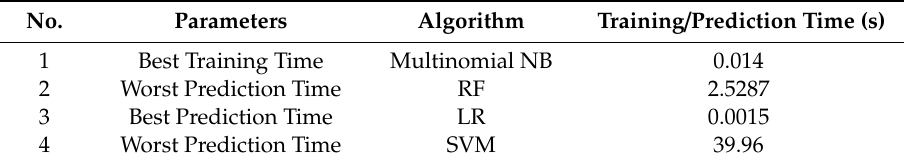
Table 3. Time Complexity of